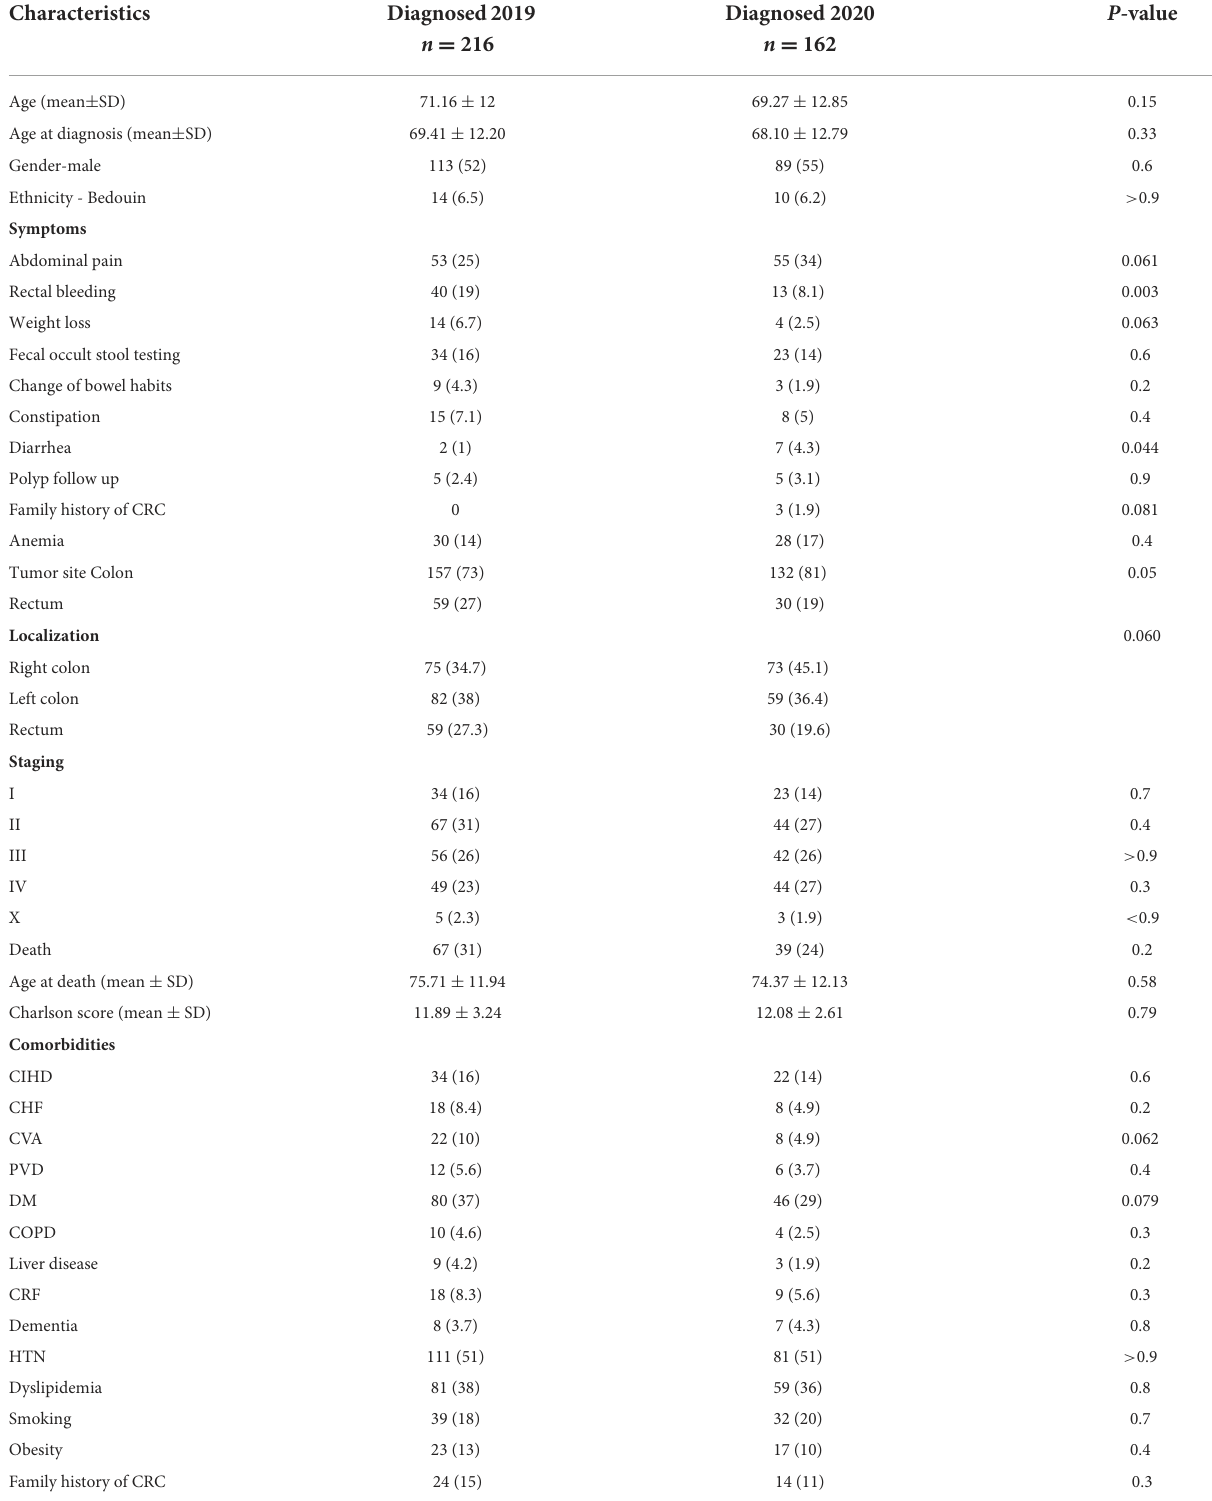
TABLE 1A Demographic and clinical characteristics of patients with CRC in the years 2019 and 2020.